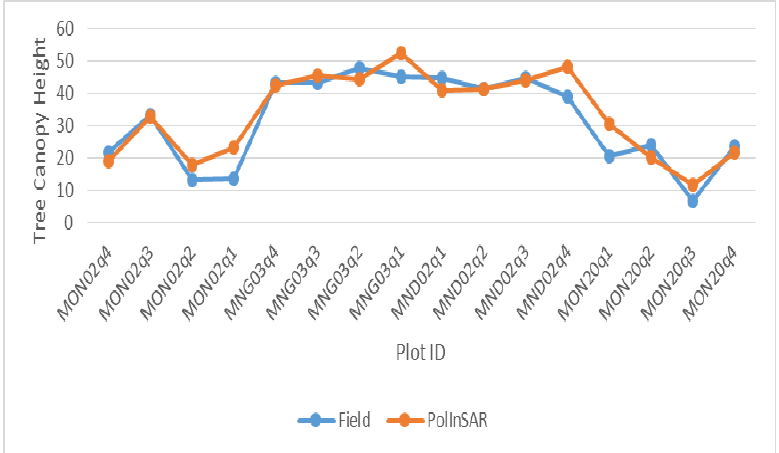
Figure 9. Field data vs estimated tree